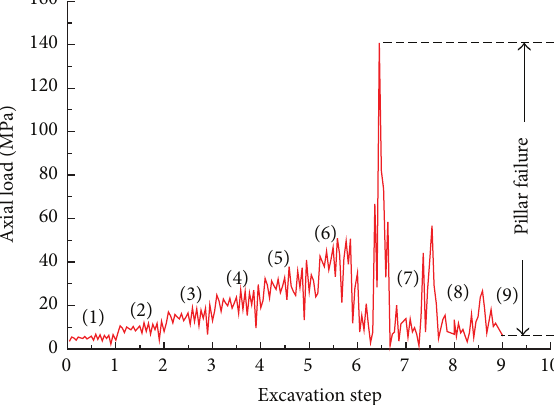
Figure 27: Pillar load history as a function of excavation